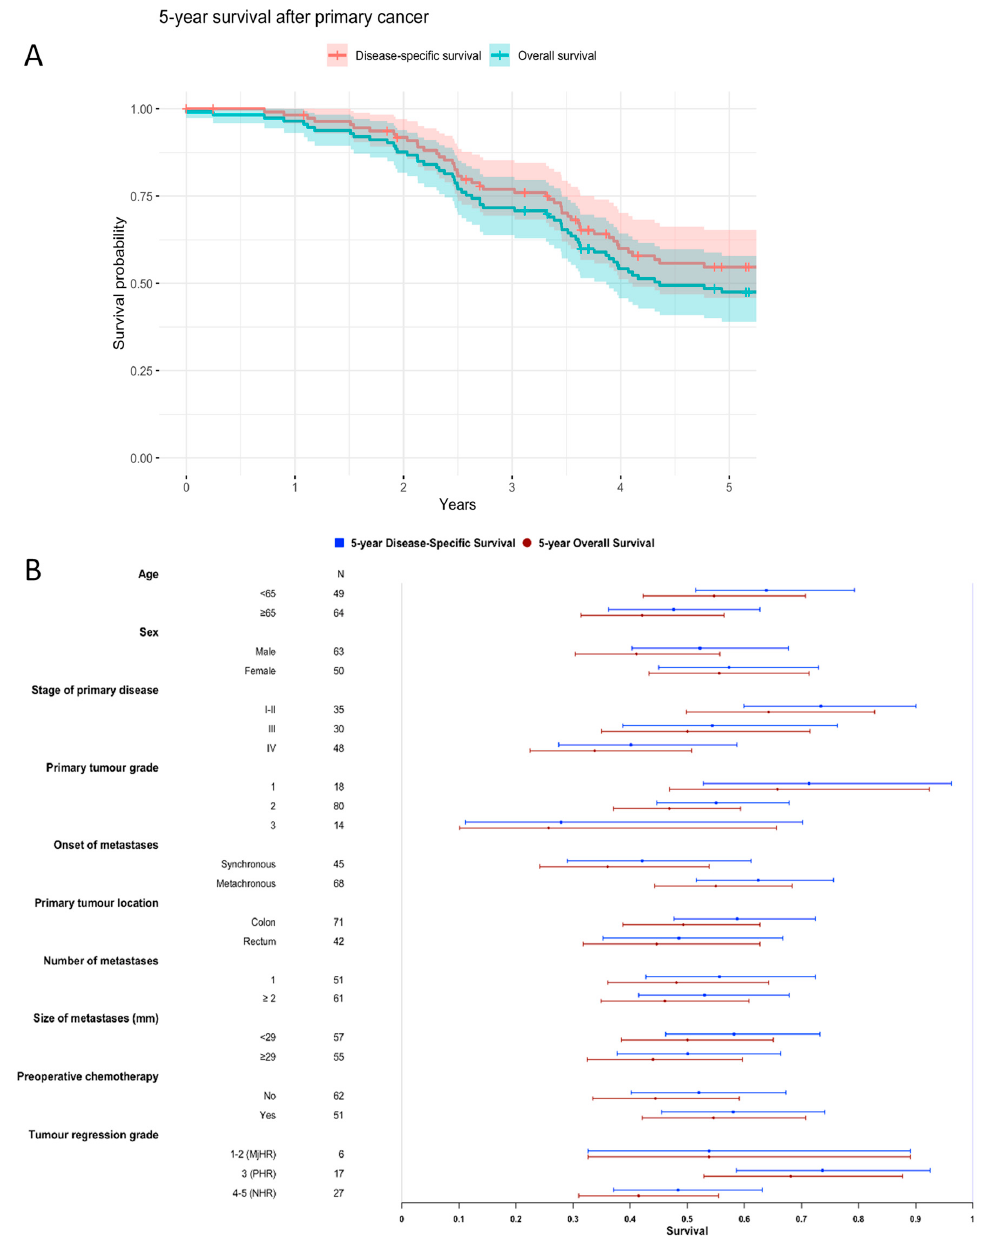
Figure 5. Kaplan-Meier curves for the entire cohort (OS and DSS) ( A ) and Forest plots for subgroup results ( B ). According to the univariable analysis, stage of primary disease, primary tumour grade, onset of metastases, primary tumour location, size of metastases, ICS and PD-L1 IC were included in the multivariable analysis together with age and sex. Table 3 shows the multivariable model with separate immune parameters for ICS and PD-L1 IC . ICS of patient’s least-infiltrated metastasis was found to be an independent prognostic